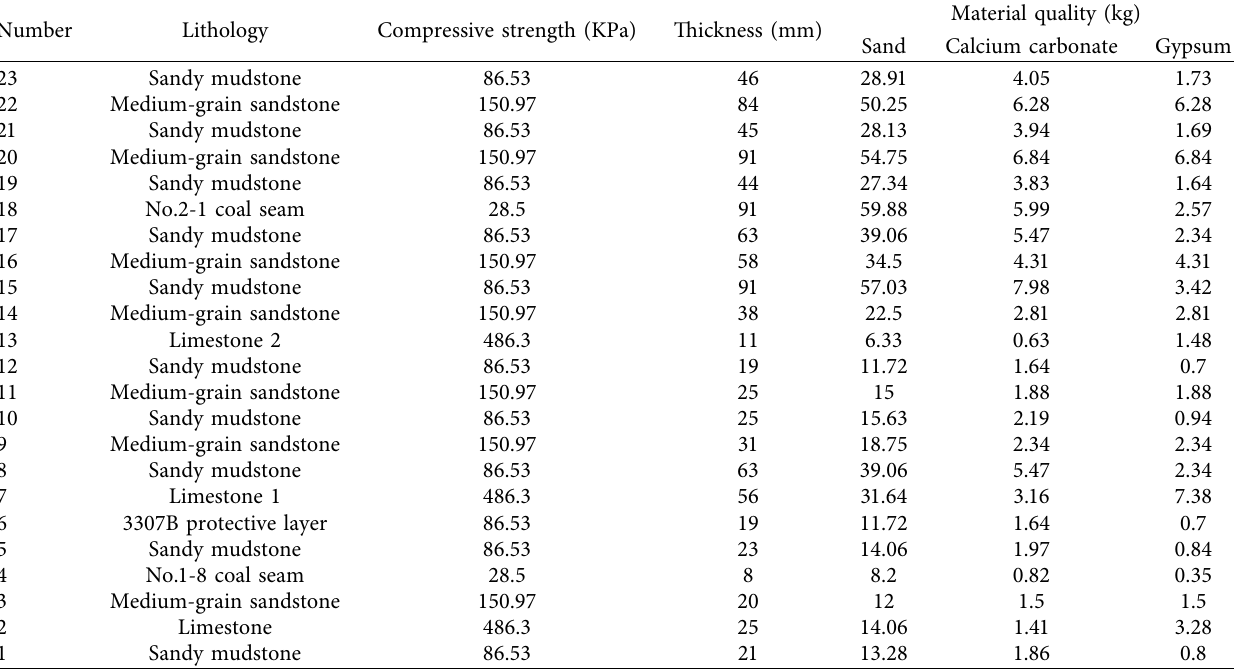
Table 2: Physical and mechanical properties of similar